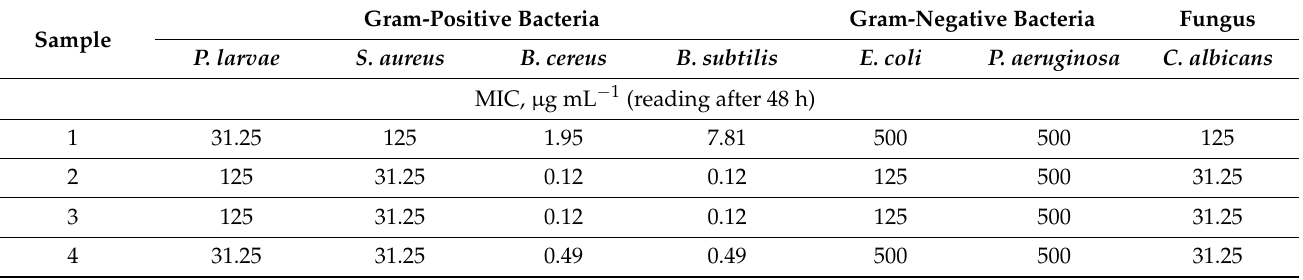
Table 5. Antimicrobial activity (MIC and MBC/MFC) of extracts from stingless bees and